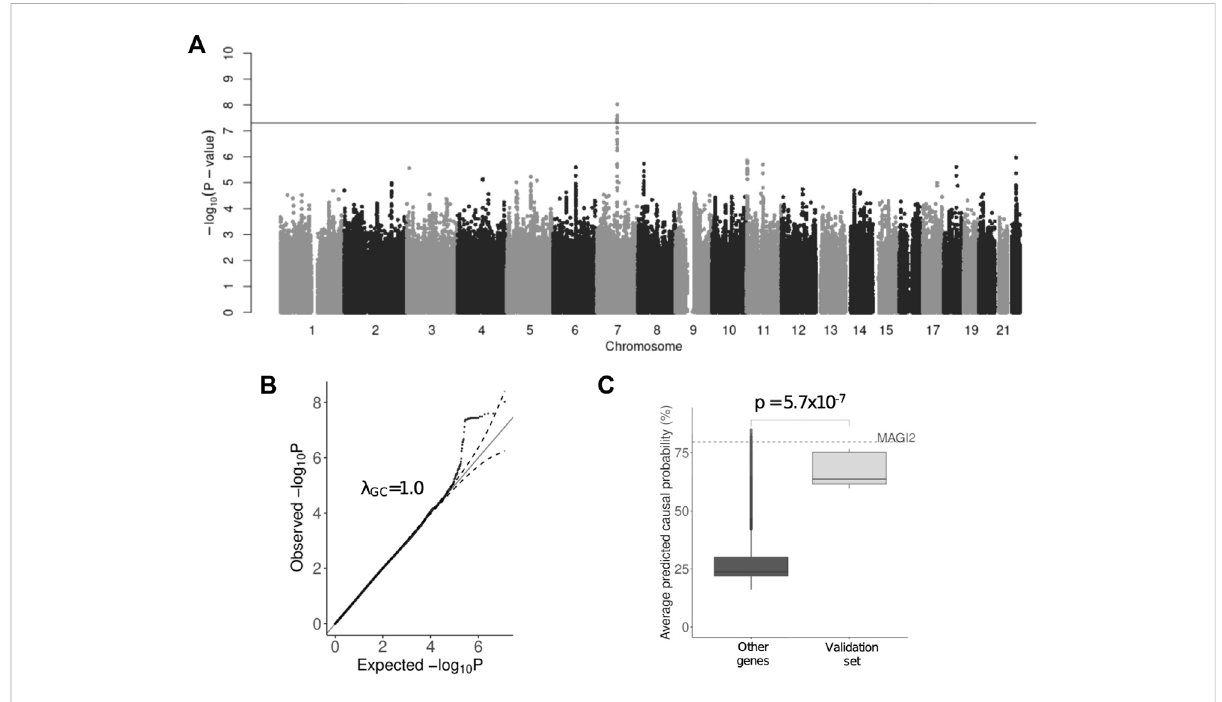
FIGURE 1 Results of the HADS-D-based GWAS. (A) Genome-wide signi fi cant signal on chromosome 7 — rs521851; (B) QQ-plot showing test statistic; (C) The results of gene prioritization using